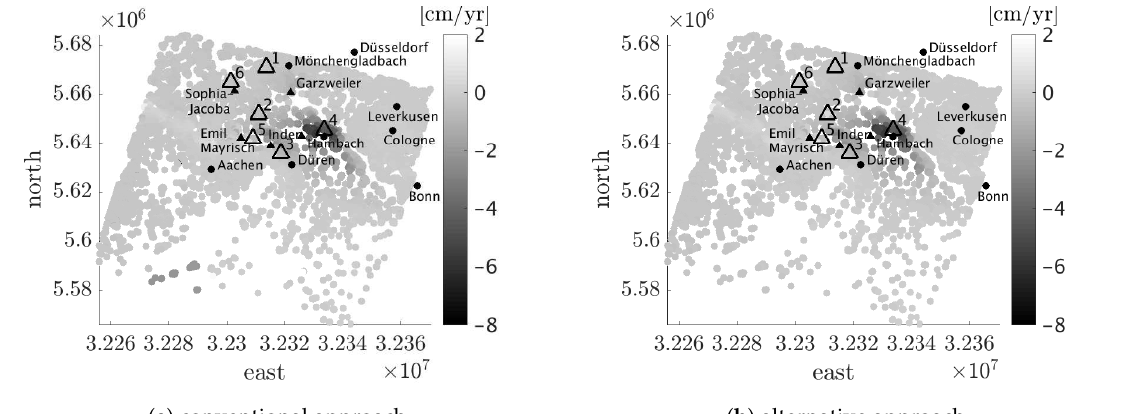
Figure 10. Mean deformation velocity map of the Lower-Rhine-Embayment based on ERS 1/2 data from May 1992 to December 2000. The deformation model is estimated using the conventional and the alternative approach. The highlighted test regions 1 to 6 are examined in more detail as a time series in Figure